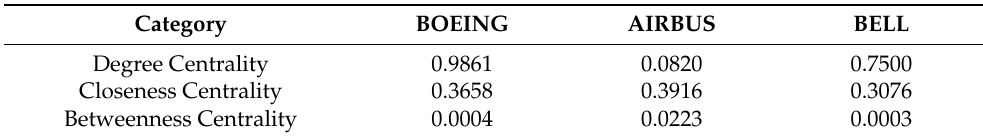
Table 12. Centrality index comparison by